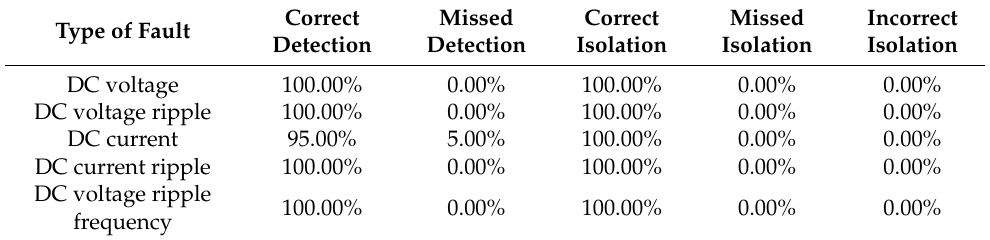
Table 8. The FDI diagnostic